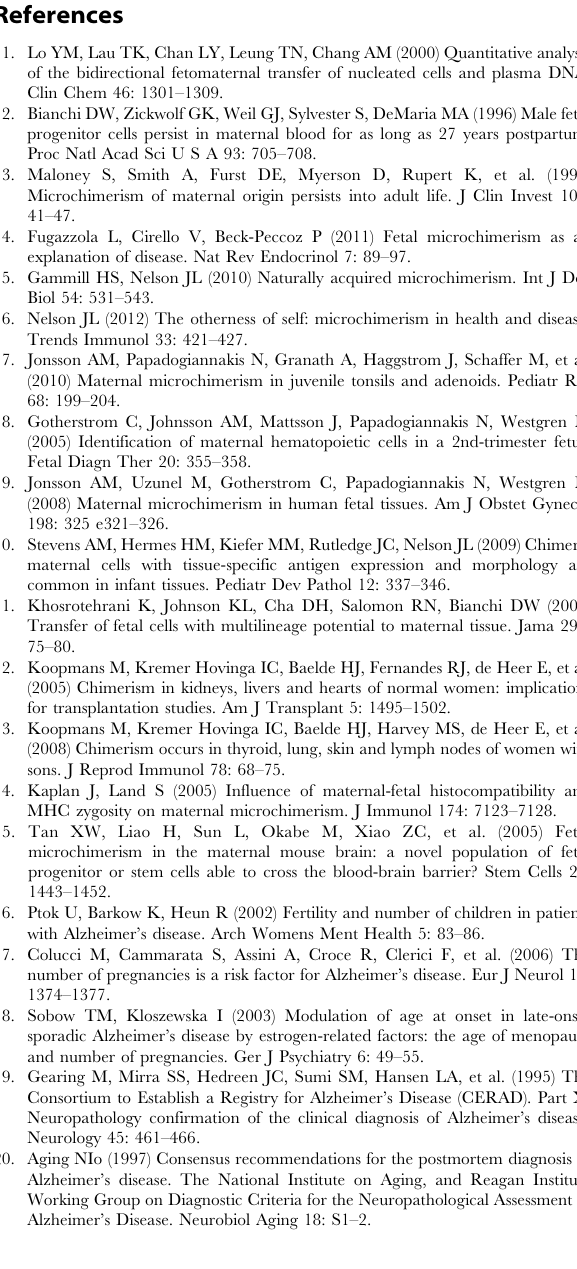
Table S1 HLA genotyping of a family for investigating fetal origin microchimerism in the mother’s brain. Table S2 Quantification of fetal origin microchimerism in the mother’s brain by HLA-specific qPCR. Table S3 Mc prevalence and concentration in women known to have at least one